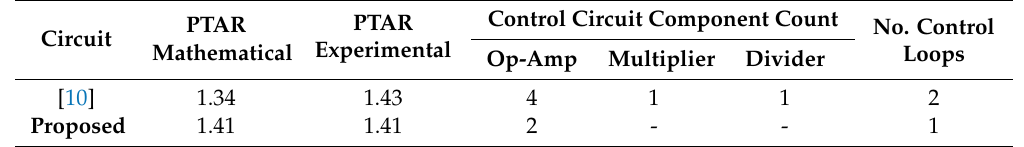
Table 3. comparison between the proposed circuit and [10].